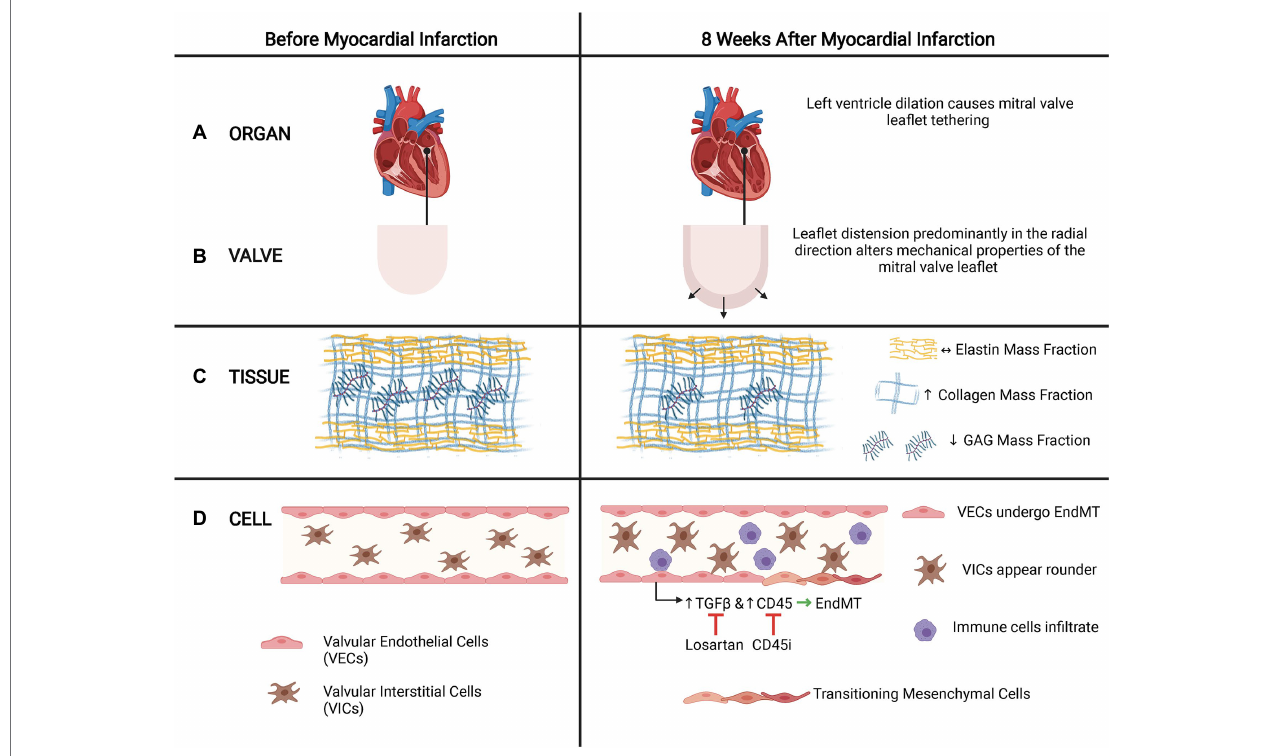
FIGURE 4 | Leaflet tethering and EndMT in ischemic mitral regurgitation (IMR). (A) . Organ. After a myocardial infarction, the heart often dilates, which causes tethering of the mitral valves that can lead to IMR. (B) Valve. Tethering distends the leaflet predominantly in the radial direction. (C) Tissue. Leaflet tethering alters the mitral valve matrix composition by increasing the collagen mass fraction and decreasing the GAG mass fraction. However, the elastic mass fraction does not change. (D) Cell. These biomechanical alterations of the valve leaflet may trigger EndMT of the mitral valve endothelial cells via mechanisms that involve TGF β signaling and CD45. Inhibiting TGF β with losartan or CD45 with a CD45 inhibitor reduces EndMT and associated maladaptive responses observed in IMR. In addition to EndMT of VECs, VICs also appear rounder and immune cells may infiltrate. (Adapted with permission from Howsmon et al.,